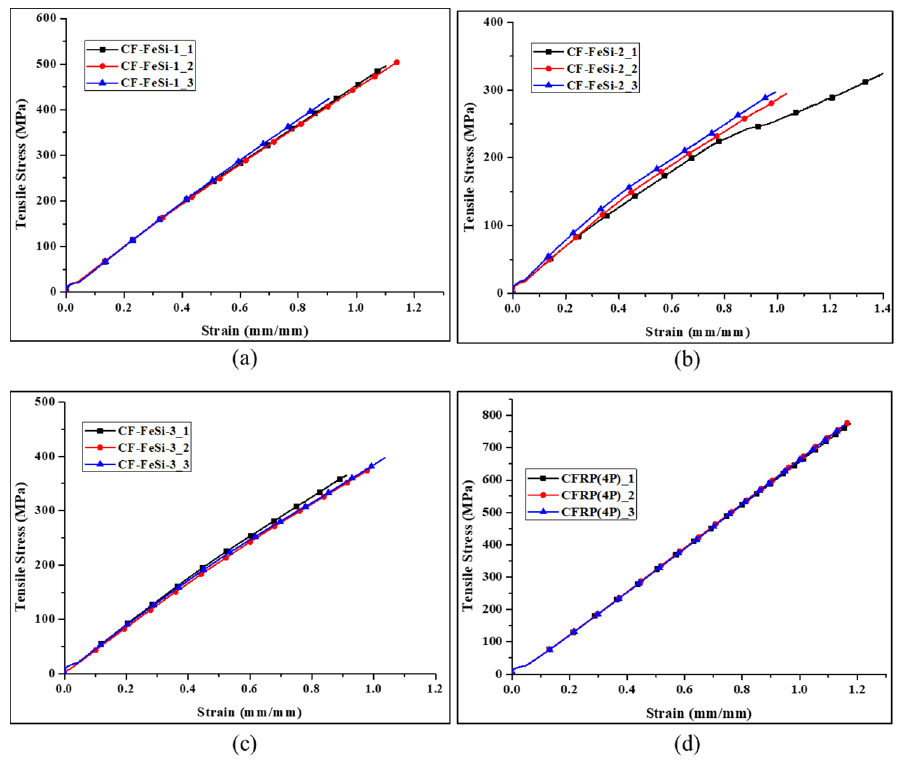
Figure9. Tensilestress–straincurvesofCFRP-FeSicomposites: ( a )CF-FeSi-1; ( b )CF-FeSi-2; (c )CF-FeSi-3; Figure 9. Tensile stress – strain curves of CFRP-FeSi composites: ( a ) CF-FeSi-1; ( b ) CF-FeSi-2; (c ) CF- ( d ) CFRP (four-ply). FeSi-3; ( d ) CFRP (four-ply). Table 7. Basic tensile properties of the CFRP-FeSi composites. Table 7. Basic tensile properties of the CFRP-FeSi composites.